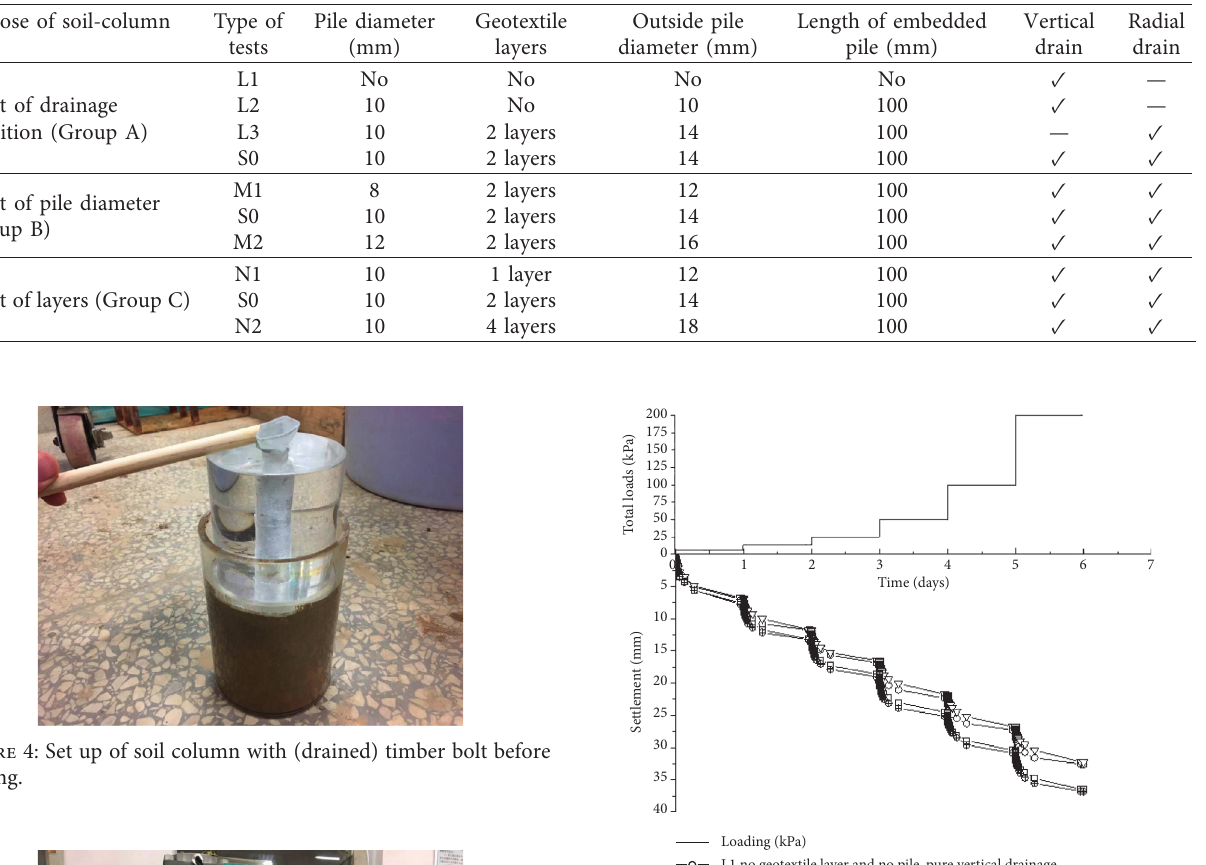
Table 2: Set up of soil-column consolidation tests with (drained) timber rods.